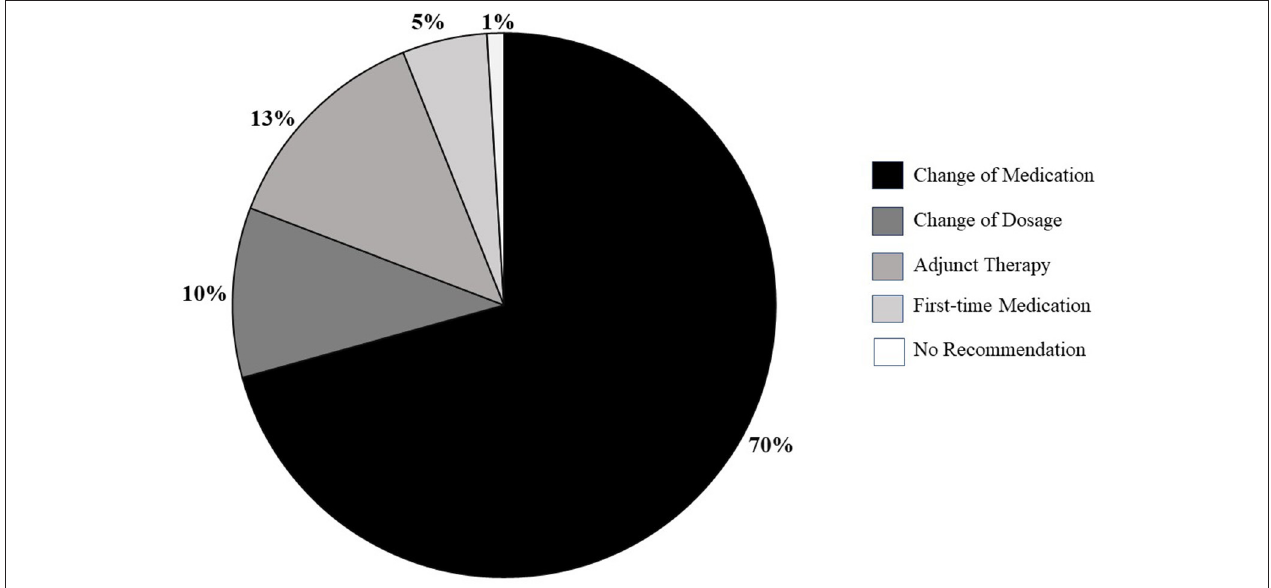
FIGURE 3 | Types of prescription changes recommended in 46 patients on mental health-related disability.